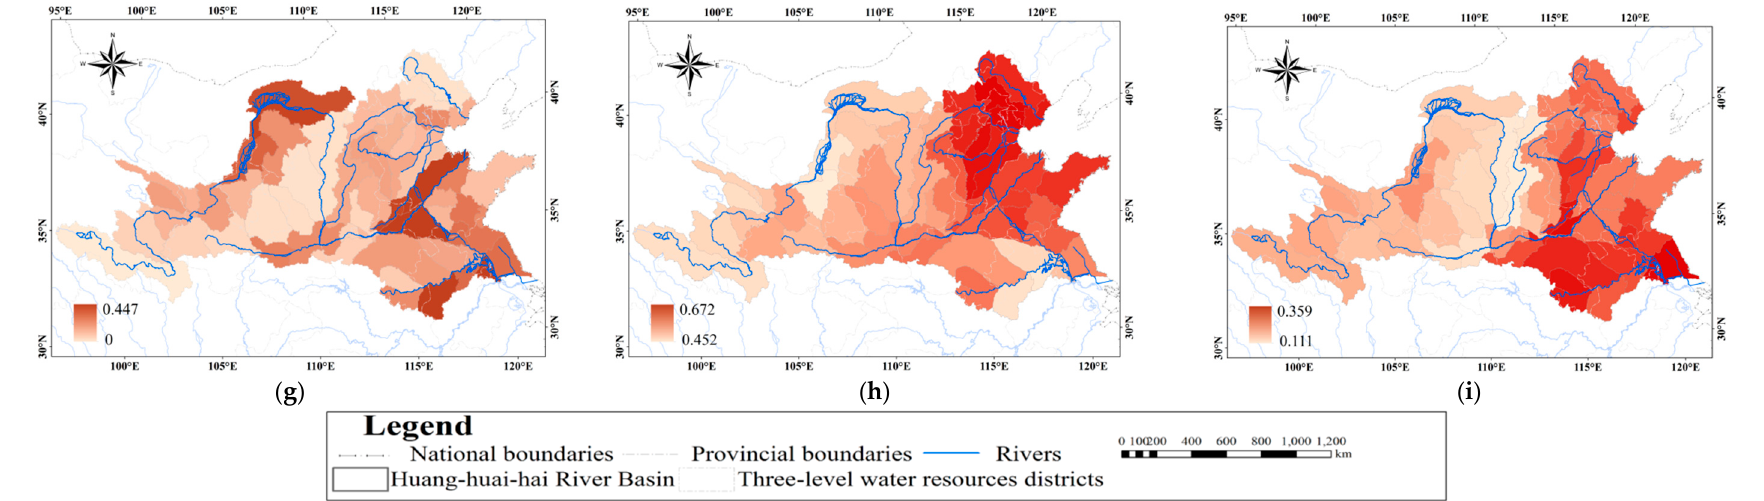
Figure 9. Density or capability of water conservancy projects in the Huang ‐ Huai ‐ Hai River Basin: ( a ) reservoir storage; ( b ) capability of rural water ‐ supply projects; ( c ) density of electromechanical wells; ( d ) design discharge of pumping stations of per unit area; ( e ) density of ditches; ( f ) capability of water lifting and water transfer projects; ( g ) density of irrigated arable land; ( h ) water efficiency of irrigation; and ( i ) proportion of arable land which can ensure stable yield despite drought or flood area.